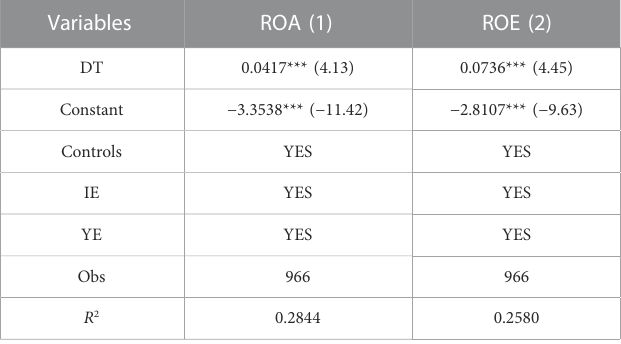
TABLE 4 Robustness check: Adding control